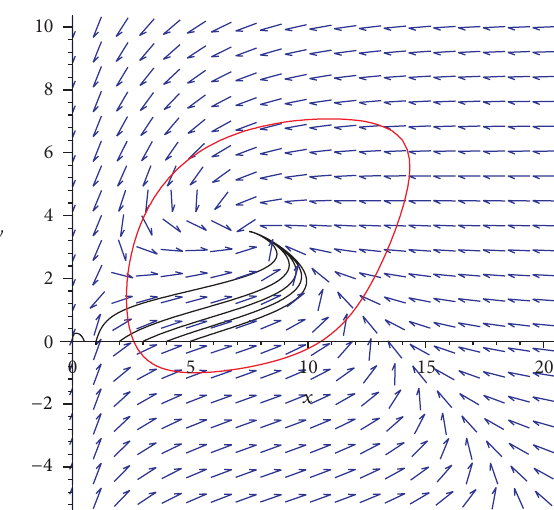
Figure 2: The DOA when (𝐴, 𝛽,𝑣, 𝑐, 𝑎, 𝜇,𝑘) = (19.2, 0.5, 1,10, 0.5, 1, 0.15) for the model